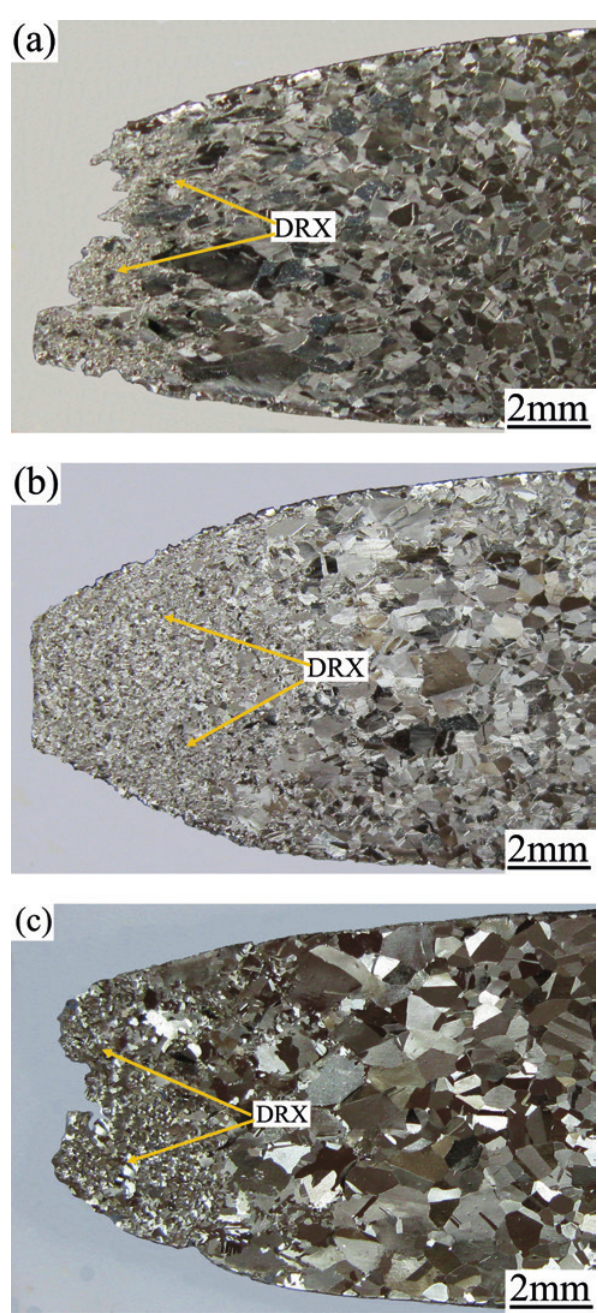
of fracture: (a) alloy 2 at 950 °C; (b) alloy 2 at 1000 °C; (a) alloy 1 at 1050